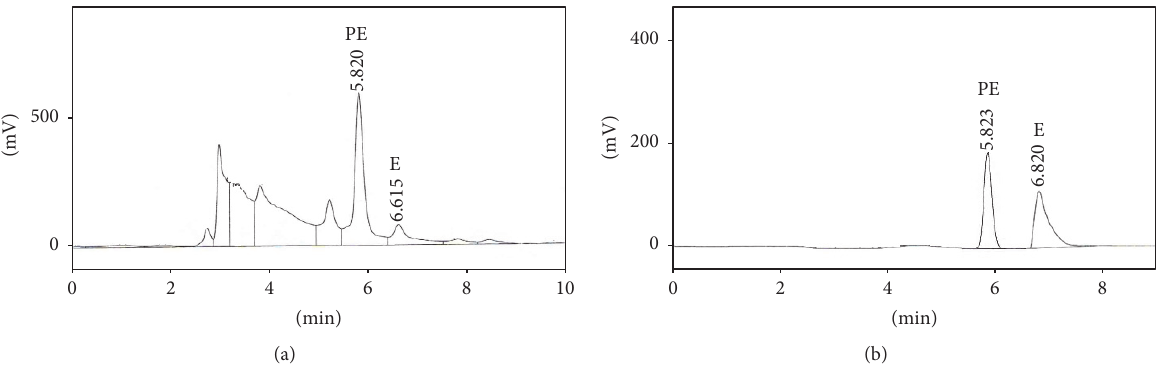
Figure 2: (a) Representative chromatograms of extracts from several E. intermedia containing (E) ephedrine and (PSE) pseudoephedrine. (b) Reference